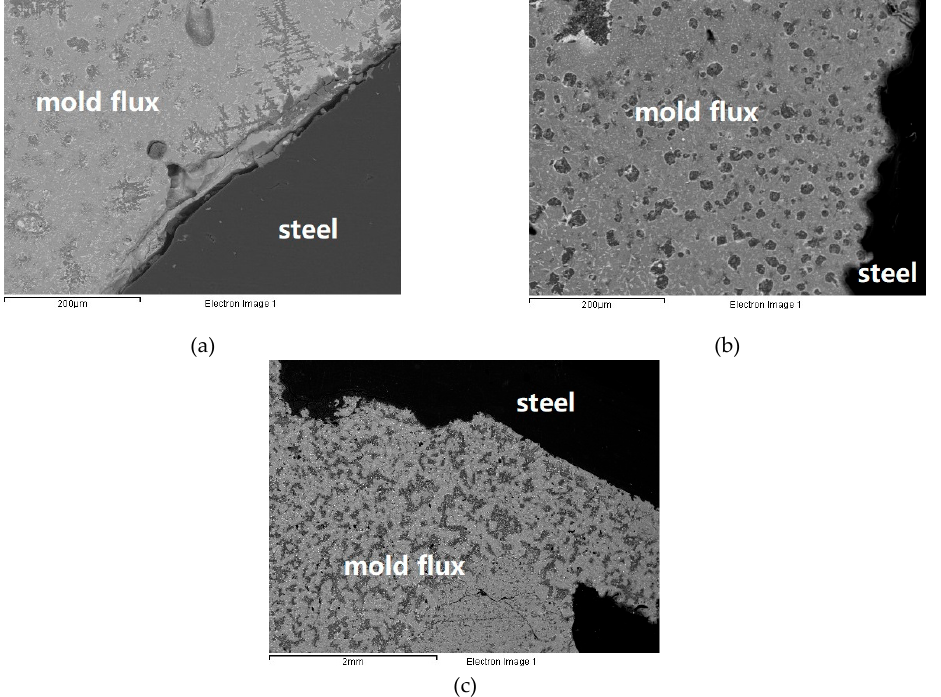
Figure 5. Crystals morphology of slag after reaction: ( a ) 10 min; ( b ) 20 min; ( c )120 min.